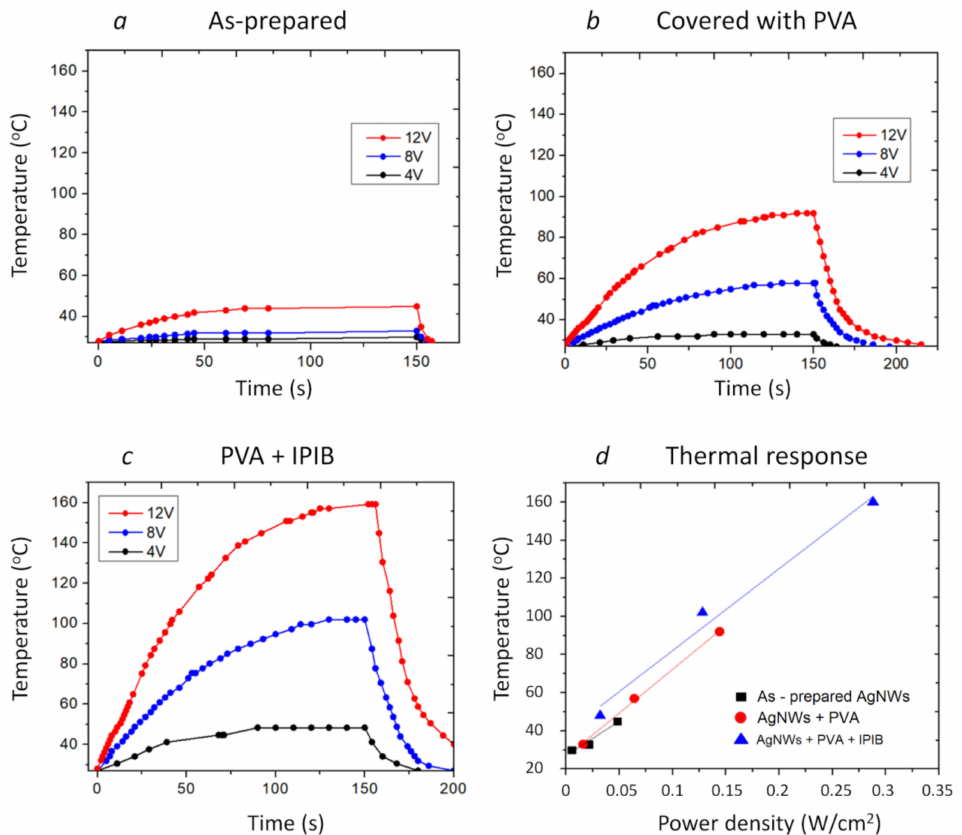
Figure 4. Transparent heater temperature dynamics, monitored by IR-camera, as a function of applied voltage (4, 8 and 12 V) for ( a ) as-prepared AgNWs, ( b ) AgNWs covered with PVA, ( c ) IPIB-irradiated AgNWs covered with PVA. ( d ) Thermal response of TCCs extracted from the temperature dynamics measurements (solid lines represent linear fit of the experimental